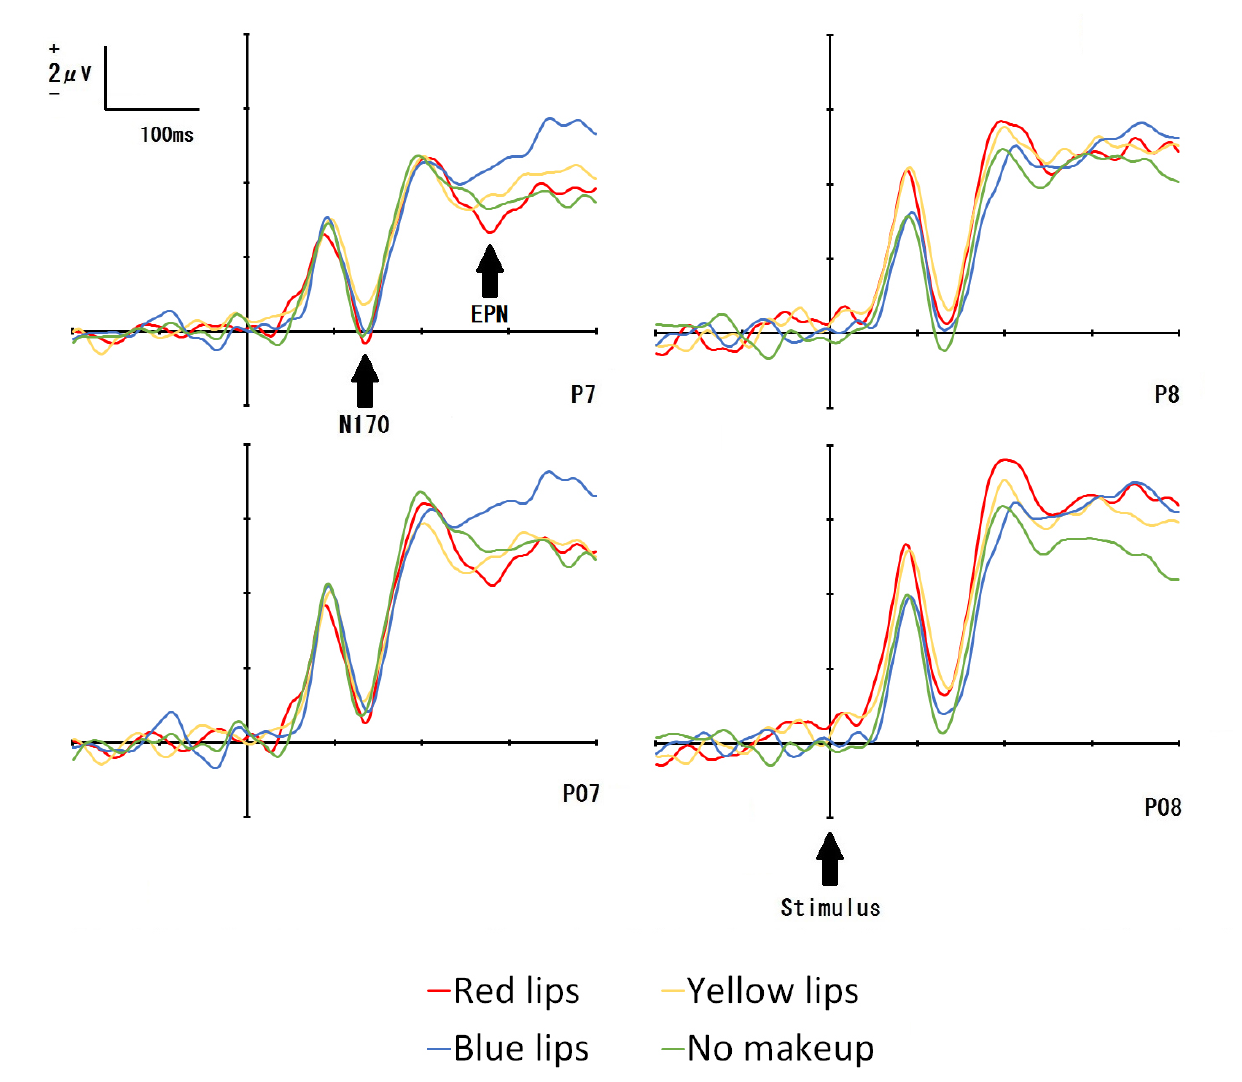
Fig. 3. Stimulus-locked average event-related potential waveforms (N170 and early posterior negativity [EPN] components) at P7, P8, PO7, and PO8 for each